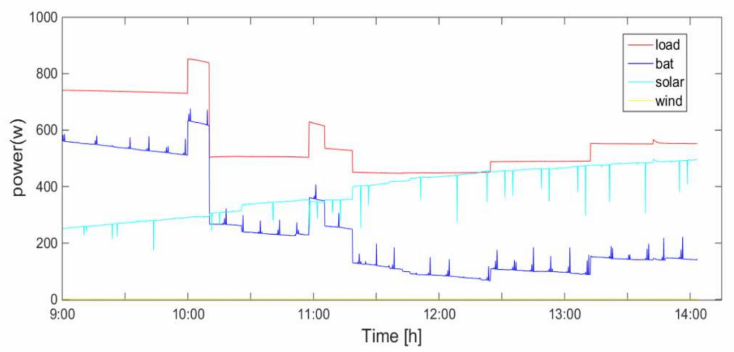
Figure 20. Power curves in scenario 7 (without the fuel cell).